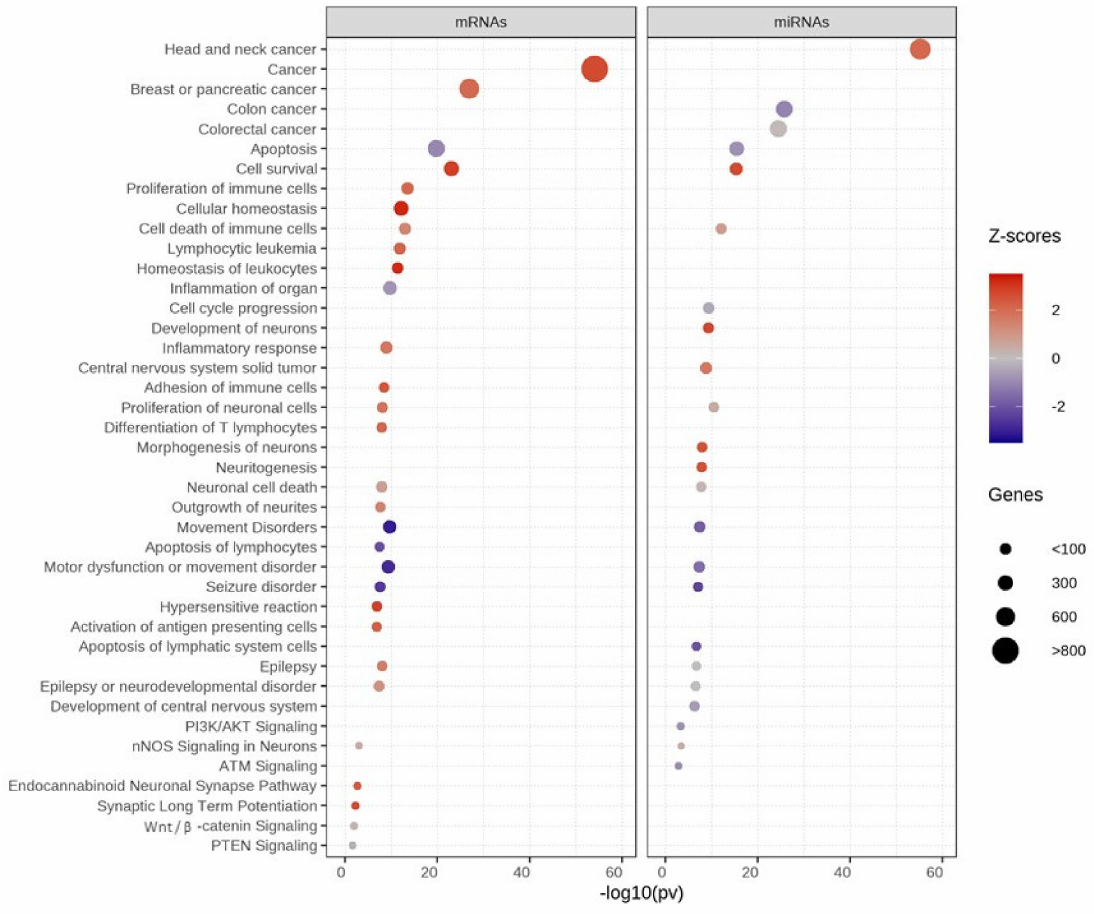
Figure 7. Functional enrichment analysis of significant mRNAs and miRNAs using IPA. Z-scores show functional enrichment. Red = activated, blue = inhibited, size of circle = number of